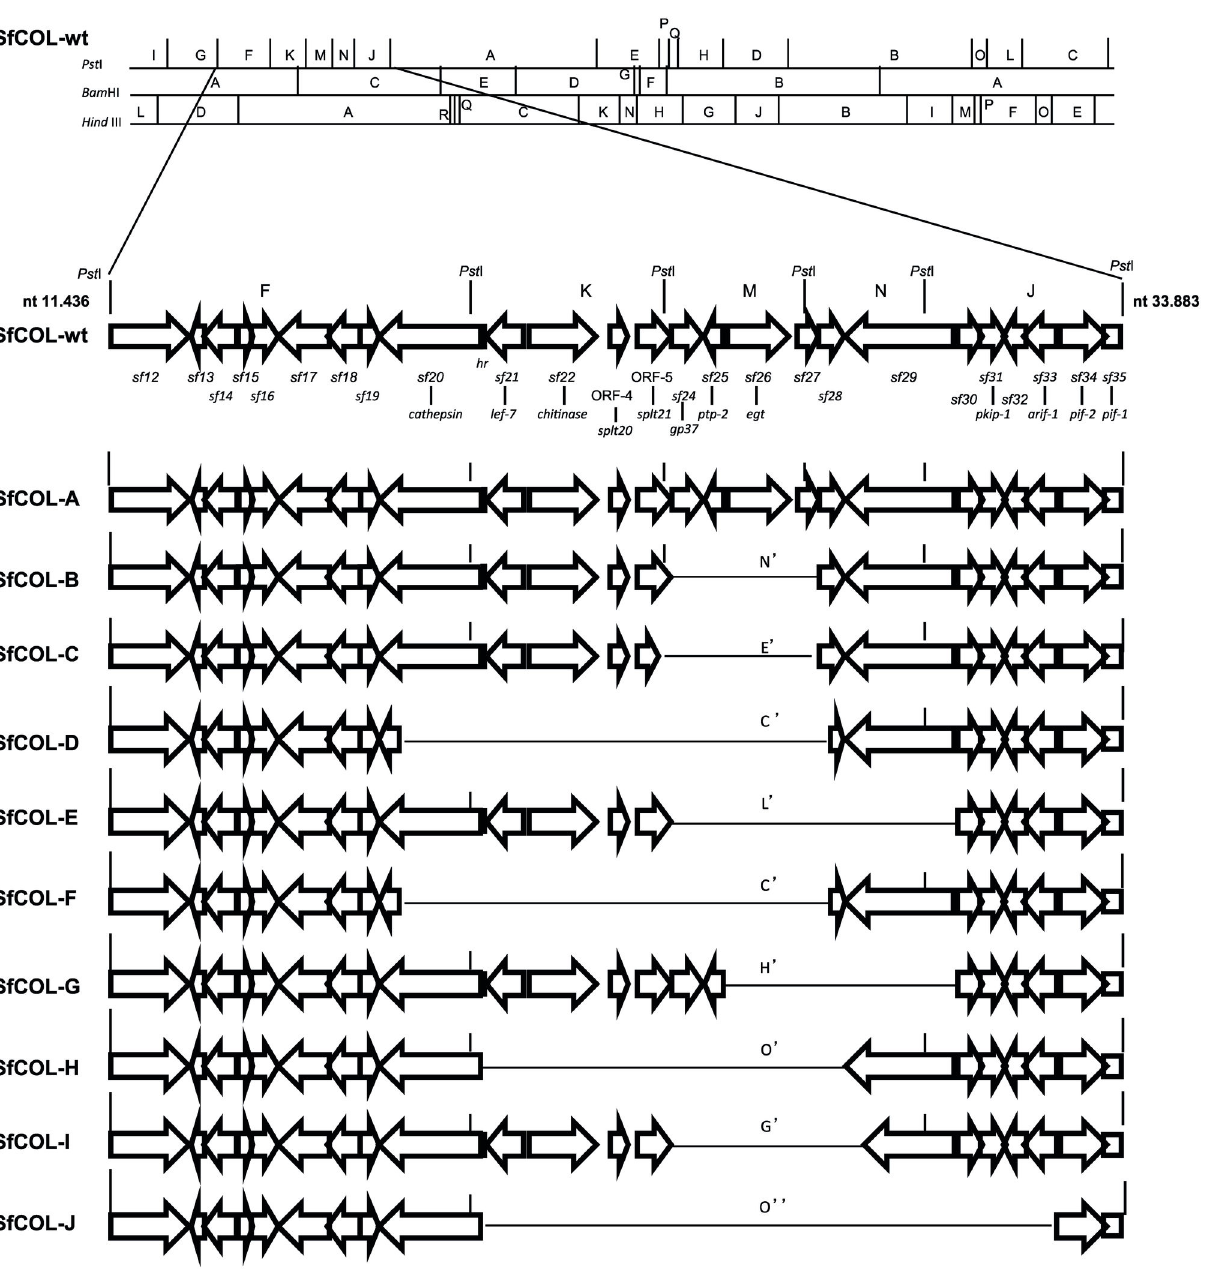
Figure 2. Physical maps of the variable regions of SfCOL genotypic variants. Schematic representation of the gene order of SfCOL genotypic variable region, including Pst I-F, -K, -M, -N, and -J fragments. The arrows represent the ORFs and point to their directions of transcription. Gene name and homologous ORFs in SfMNPV genome are indicated below the SfCOL-wt genome.